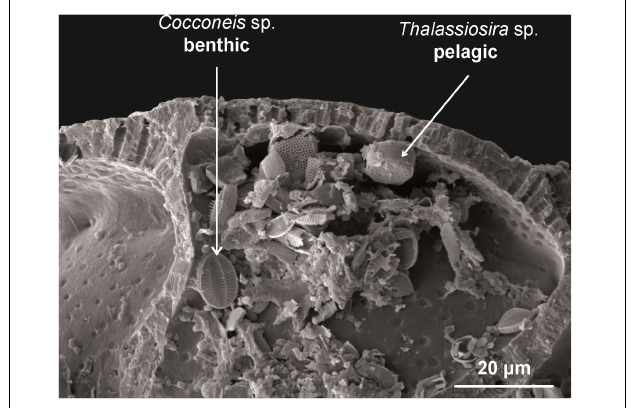
FIGURE 4 | SEM-image. Cracked chamber of Ammonia tepida containing benthic ( Cocconeis sp.) and pelagic diatoms ( Thalassiosira